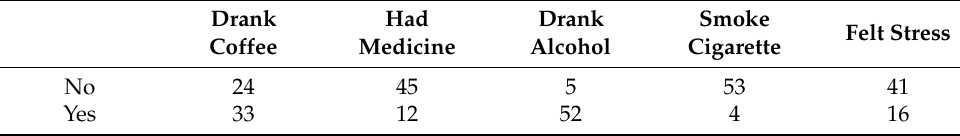
Table 1. Substances ingested or felt, in the 24 h, before the